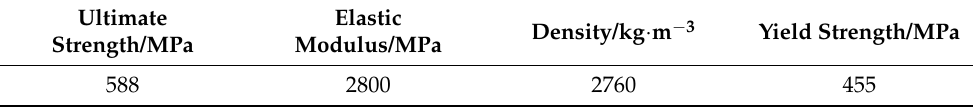
Table 2. Mechanical properties of aluminum alloy